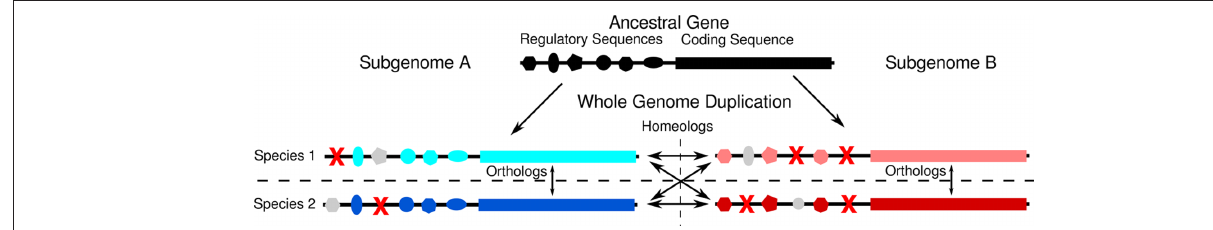
Figure 4 | Model for how duplicated genes come to possess different numbers of CNSs. A hypothetical example of how regulatory sequences of duplicate genes might evolve following whole genome duplication. The original whole genome duplication creates two homeologous copies of an ancestral gene, both of which evolve separately in two species, rice and sorghum that arose from the original tetraploid species. Red X’s mark deleted sequences. Gray shapes represent intact regulatory elements which